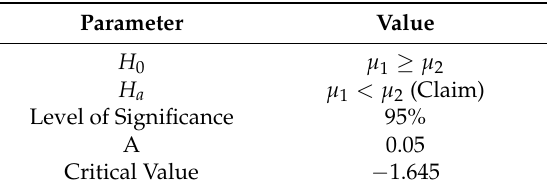
Table 4. Parameters z test.